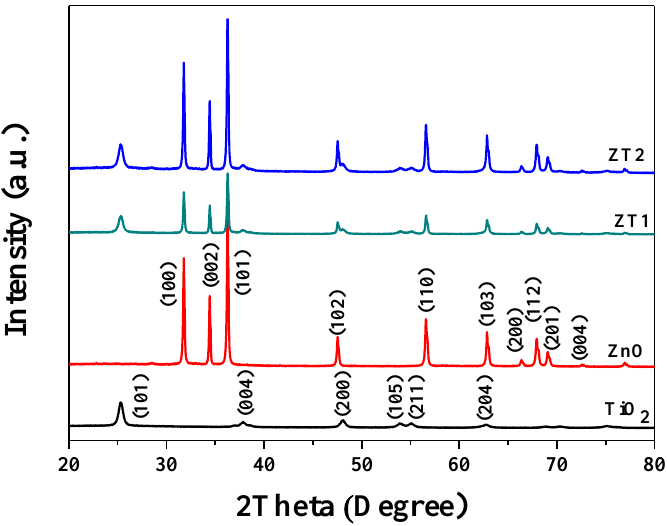
Figure 3. XRD patterns of different photoanode films.